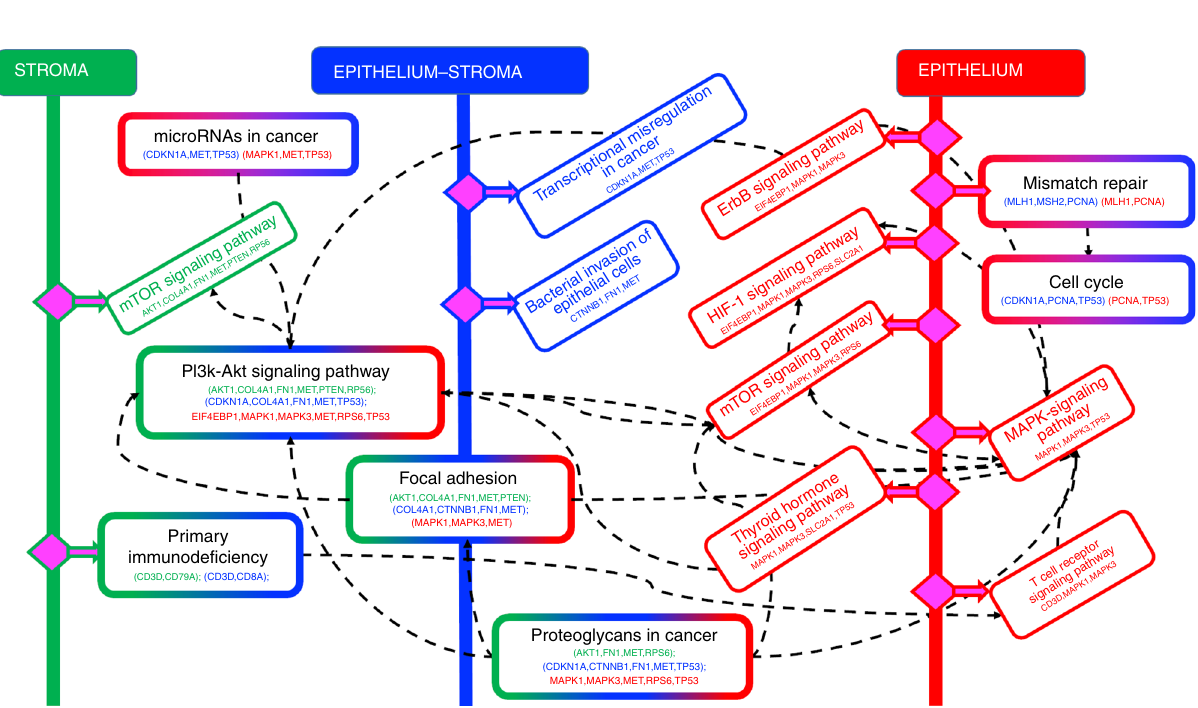
Fig. 6 CRC-recurrence-speci fi c network biology inferred by SpAn. Domain-speci fi c biomarkers identi fi ed by the spatial-domain networks are used to interrogate the KEGG and STRING databases to identify domain-speci fi c pathways enriched by the biomarkers. The epithelial, stromal, and epithelial- stromal domain are, respectively, shown in green, red, and blue, with pathways unique to those domains also coded with the same colors. Pathways that are enriched in more than one domain are coded with a color combination of those respective domains. For example, the PI3K-AKT signaling pathway is enriched in all three spatial domains, and therefore, has a boundary box color-coded with all three colors. On the other hand, the mismatch repair pathway is enriched in the epithelial and epithelial-stromal domains, and is therefore, color-coded by red and blue